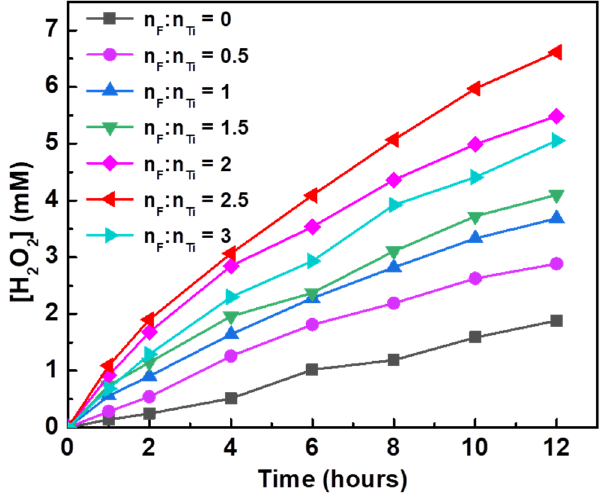
Figure 5. Photocatalytic H 2 O 2 production over 0.1% Au/F-TiO 2 prepared with different F/Ti ratios.